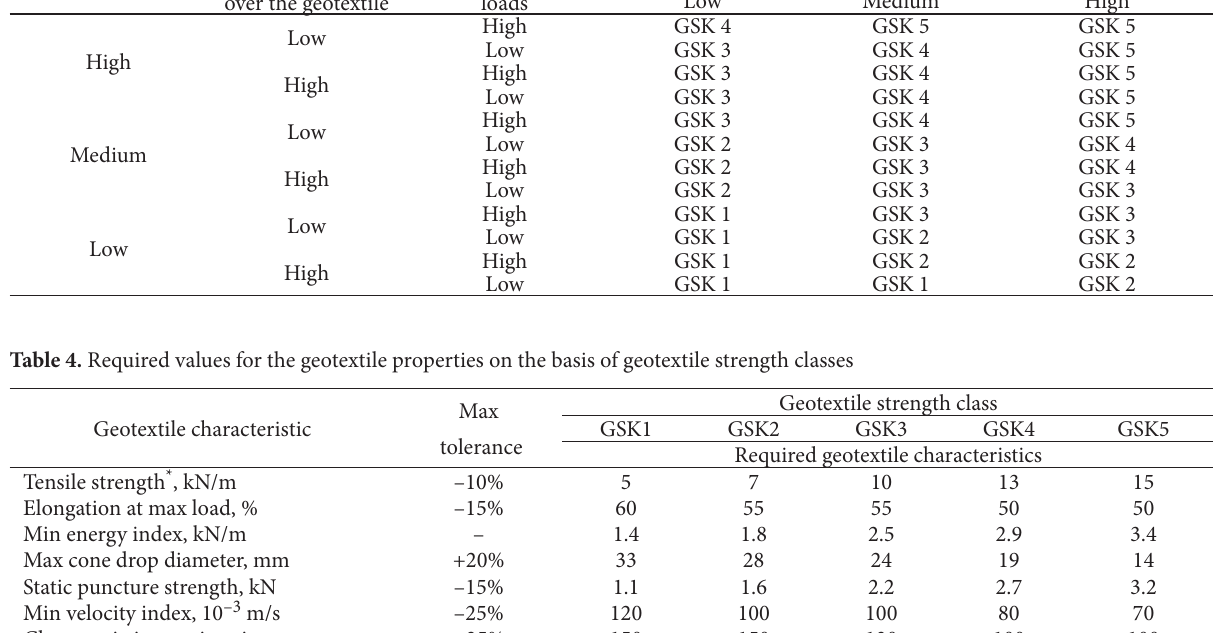
Table 3. Geotextile strength classes depending on the combinations of factors, having the impact on the geotextile damages and on the fulfilment of the separation function Installation loads